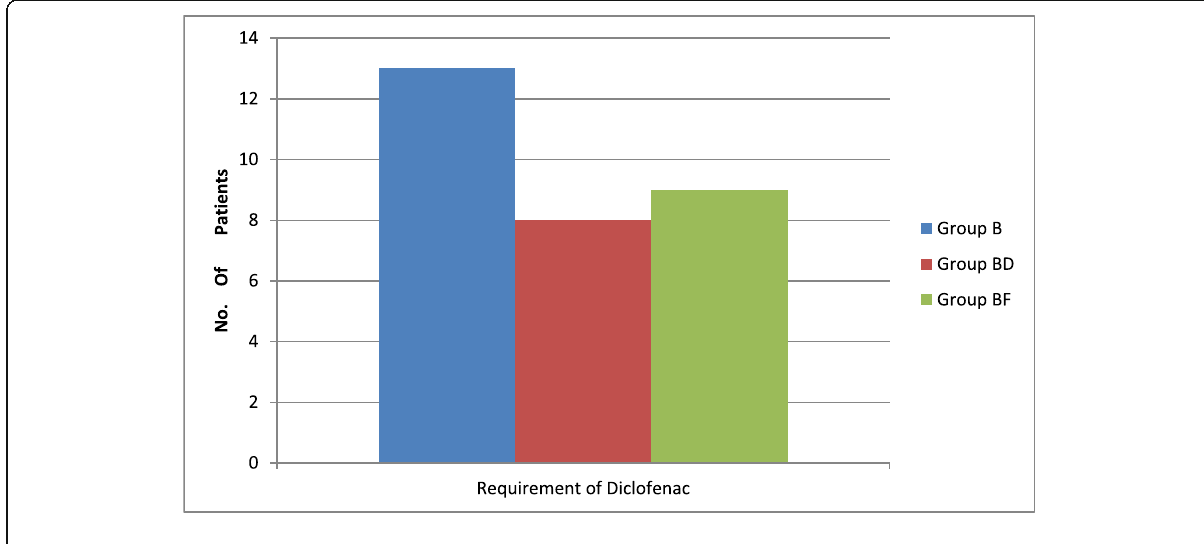
Fig. 4 Number of patients requiring rescue